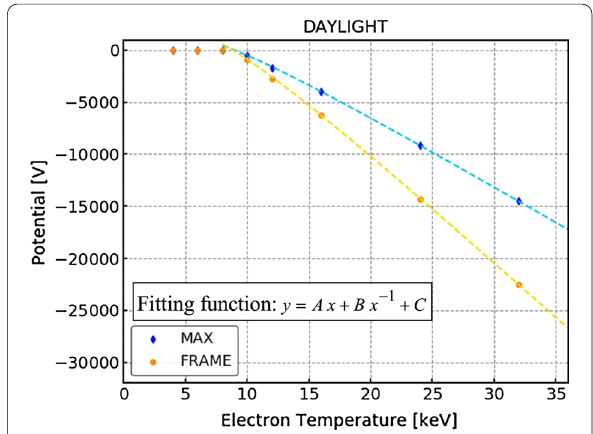
Fig. 6 Frame and maximum surface potentials estimated by SPIS with the geometric model of Michibiki‑1 satellite under daylight